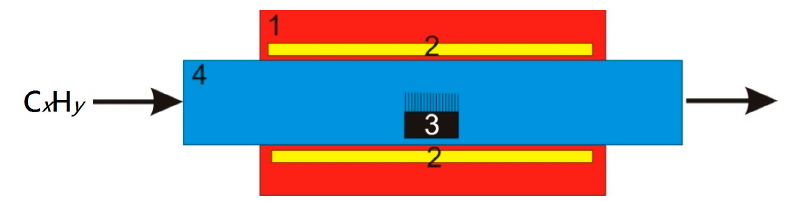
Figure 1. Setup of CVD reactor for CNT synthesis where: 1—furnace; 2—furnace heating elements; 3—substrate with growing nanotubes; 4—reaction tube [41].